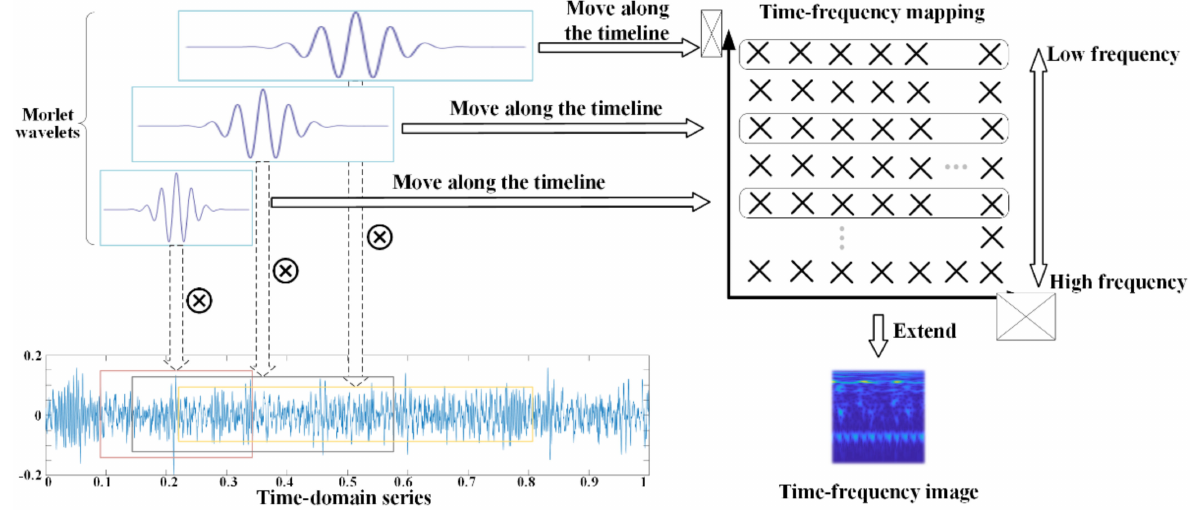
Figure 3. Time-frequency transformation from vibration signals to images using